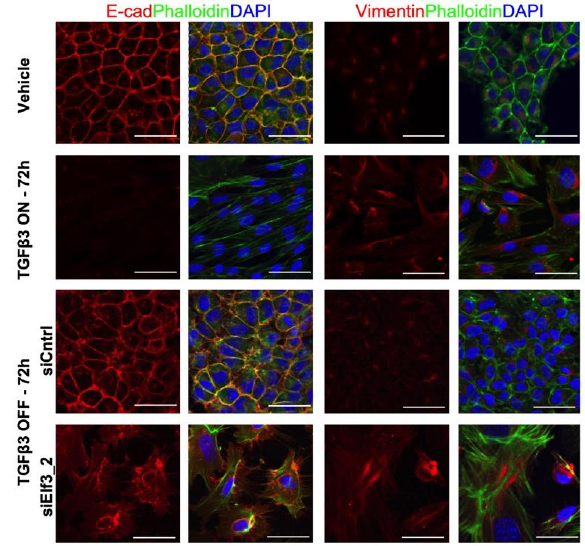
Figure 2. The siRNA-mediated silencing of Elf3 result in an impaired MET. Confocal images showing the immunofluorescence staining of NMuMG cells visualizing changes in expression and intracellular distribution of E-cadherin, Vimentin, and Actin during TGFβ3 treatment, withdrawal, and also during the silencing of Elf3 . Actin distribution (Phalloidin, green) and detection of E-cadherin (red) and Vimentin (red) is shown. Nuclei are labeled with DAPI. Scale bar, 50 µm.